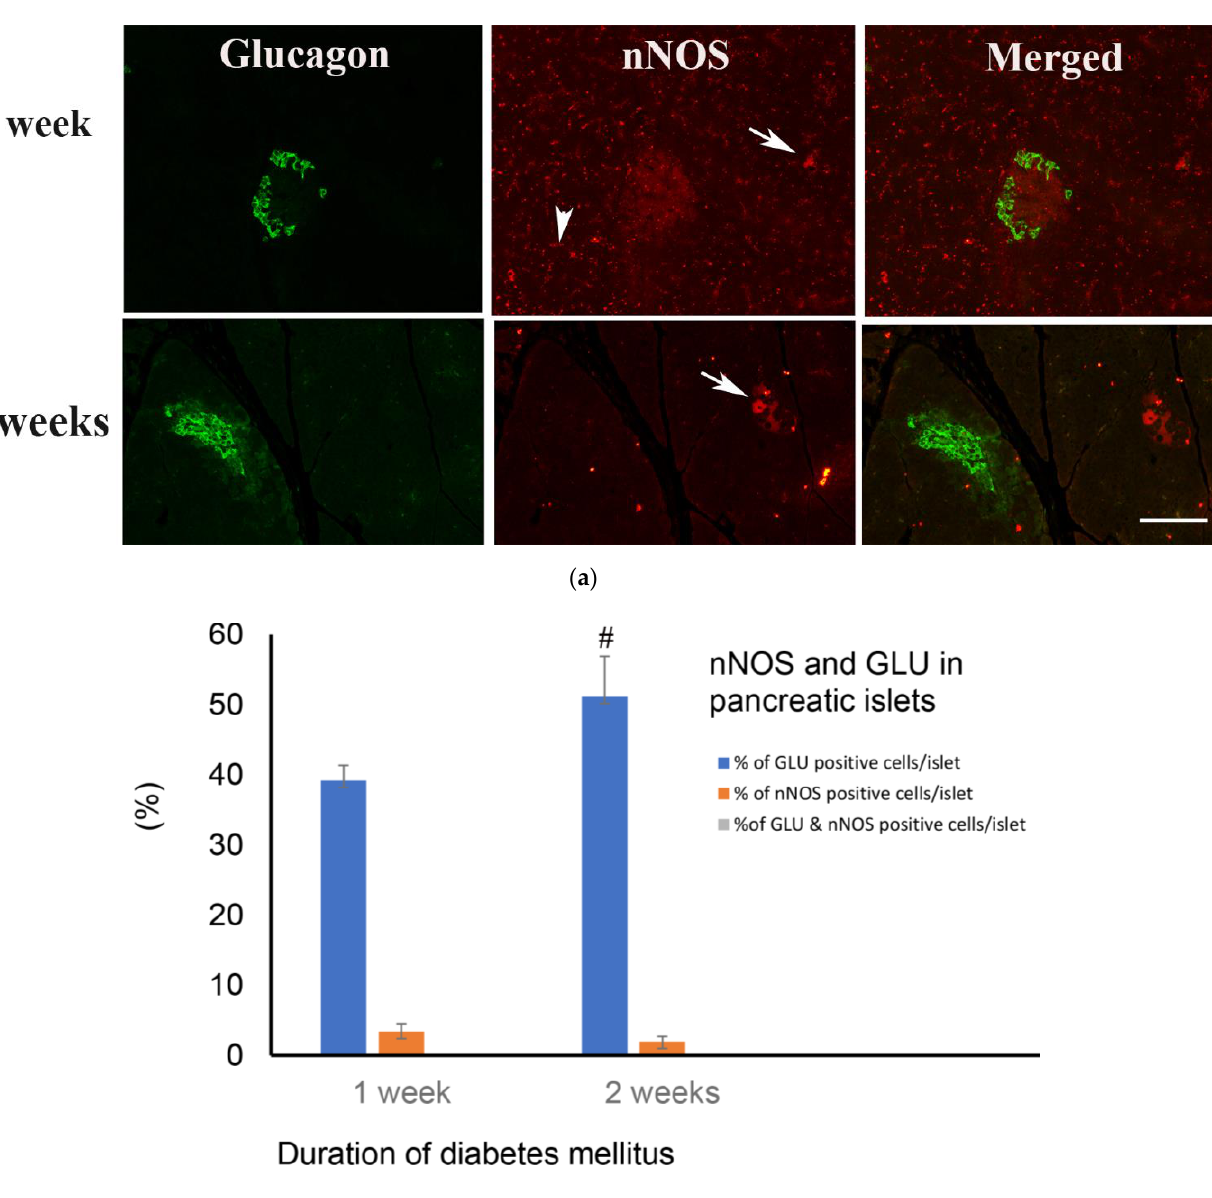
Figure 7. ( a ) shows glucagon (GLU)-(green) and nNOS-(red)-immuno-positive cells in pancreatic islets of rats 1 and 2 weeks after the onset of diabetes. There was no co-localization between glucagon and nNOS. nNOS-immunoreactive ganglion cell (arrow) and nerve fibres (arrow head) were observed in the exocrine pancreas. Scale bar = 10 µ m. ( b ) shows morphometric analysis of the glucagon-positive cells in the islet cells of the endocrine pancreas. Note the slight but significant (# p < 0.01) increase in the number of glucagon-positive cells 2 weeks after induction of diabetes, when compared to week 1 (n =